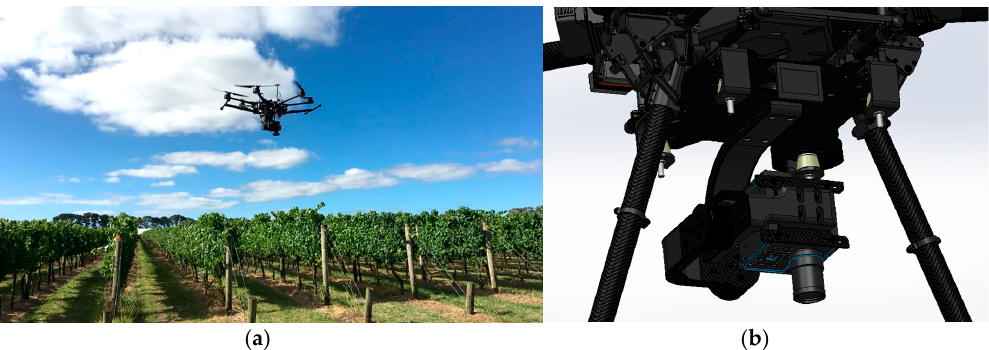
Figure 5. ( a ) Headwall Nano hyperspectral sensor on-board a S800 unmanned aerial vehicle (UAV); ( b ) Custom-made two-axis gimbal hosting the hyperspectral camera (SolidWorks 3D model).